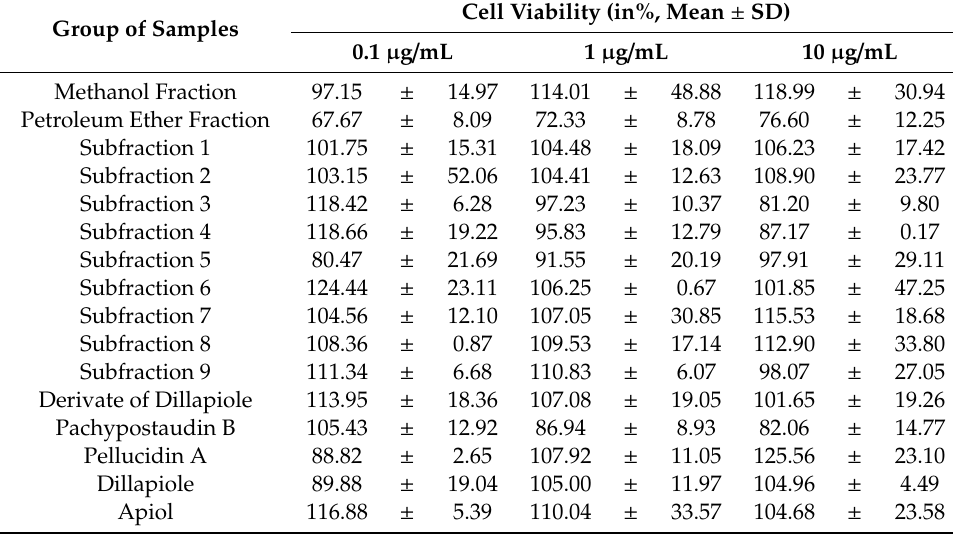
Table 2. Viability test results of tested samples from P. pellucida using the WST-1 cell proliferation assay. Group of